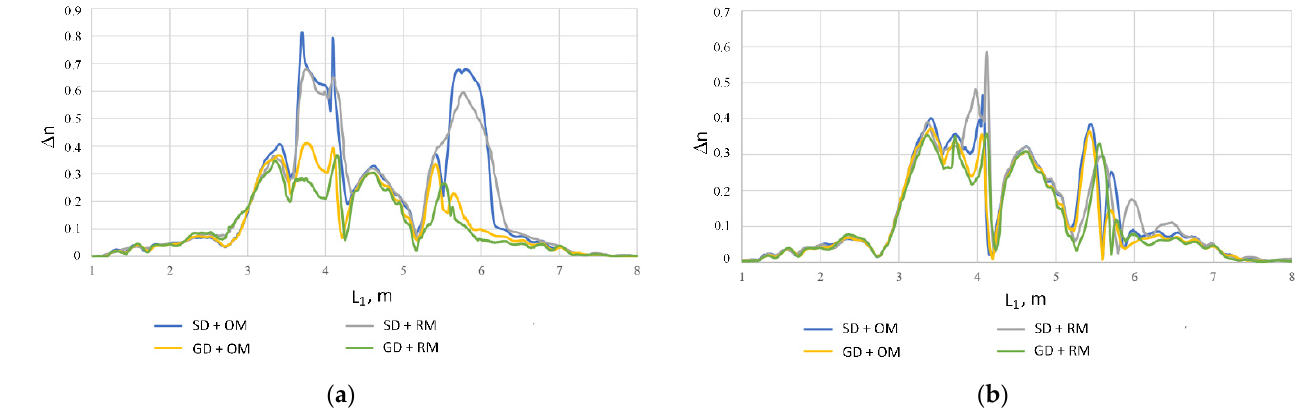
Figure 13. The values of the relative differences in the rotational speed of the road wheels during the simulation when the vehicle model was driven through the ditch at the maximum value of the coefficient of adhesion φ = 0.3 ( a ) oraz φ =0.7 ( b ): GD—gear-type flow divider, SD—spool-type flow divider, OM—orbital motor, RM—radial piston motor.